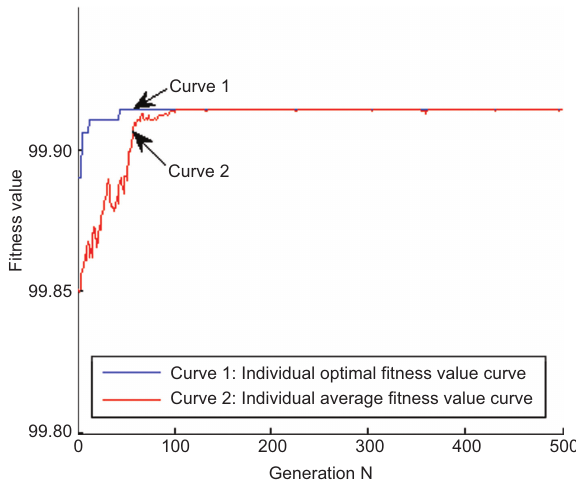
Figure 12. The Convergence Curve when the Mutation Probability is Set to (0.004, 0.002).